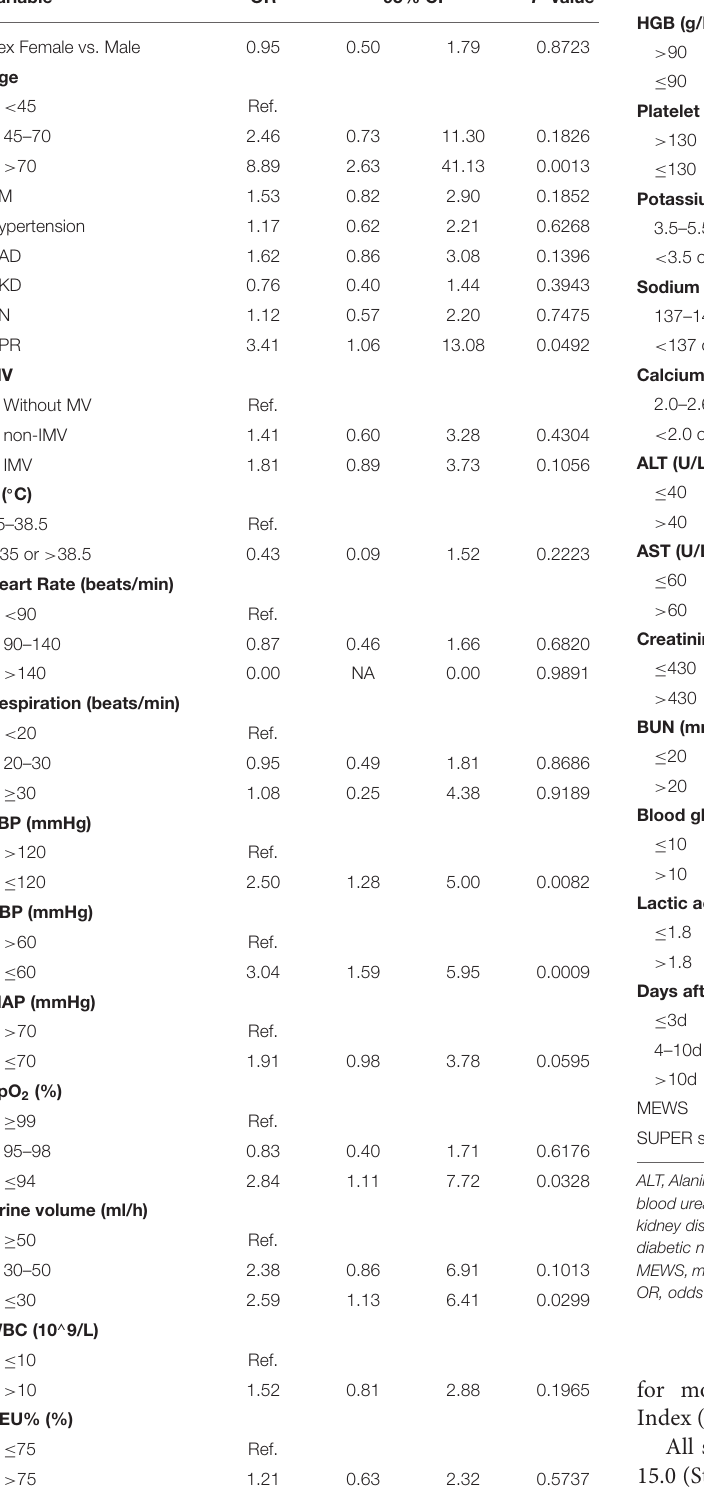
TABLE 2 | Univariate logistic regression analysis of in-hospital mortality in the training cohort. Variable OR 95% CI P- value Sex Female vs. Male